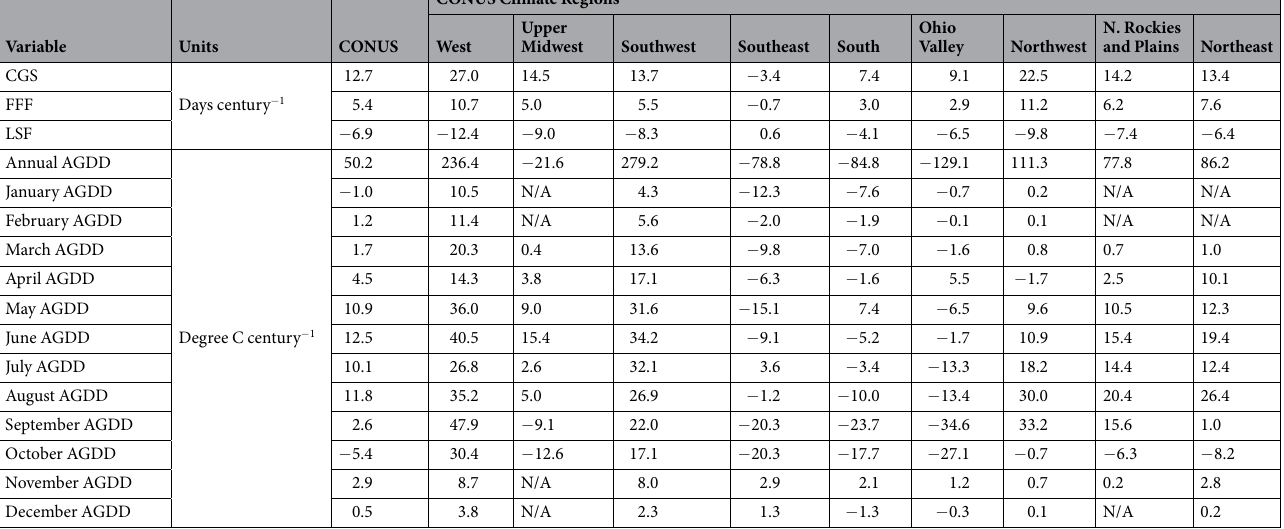
Table 2. Trends in agroclimate indices for the CONUS climate regions. Cells with N/A indicate that a trend